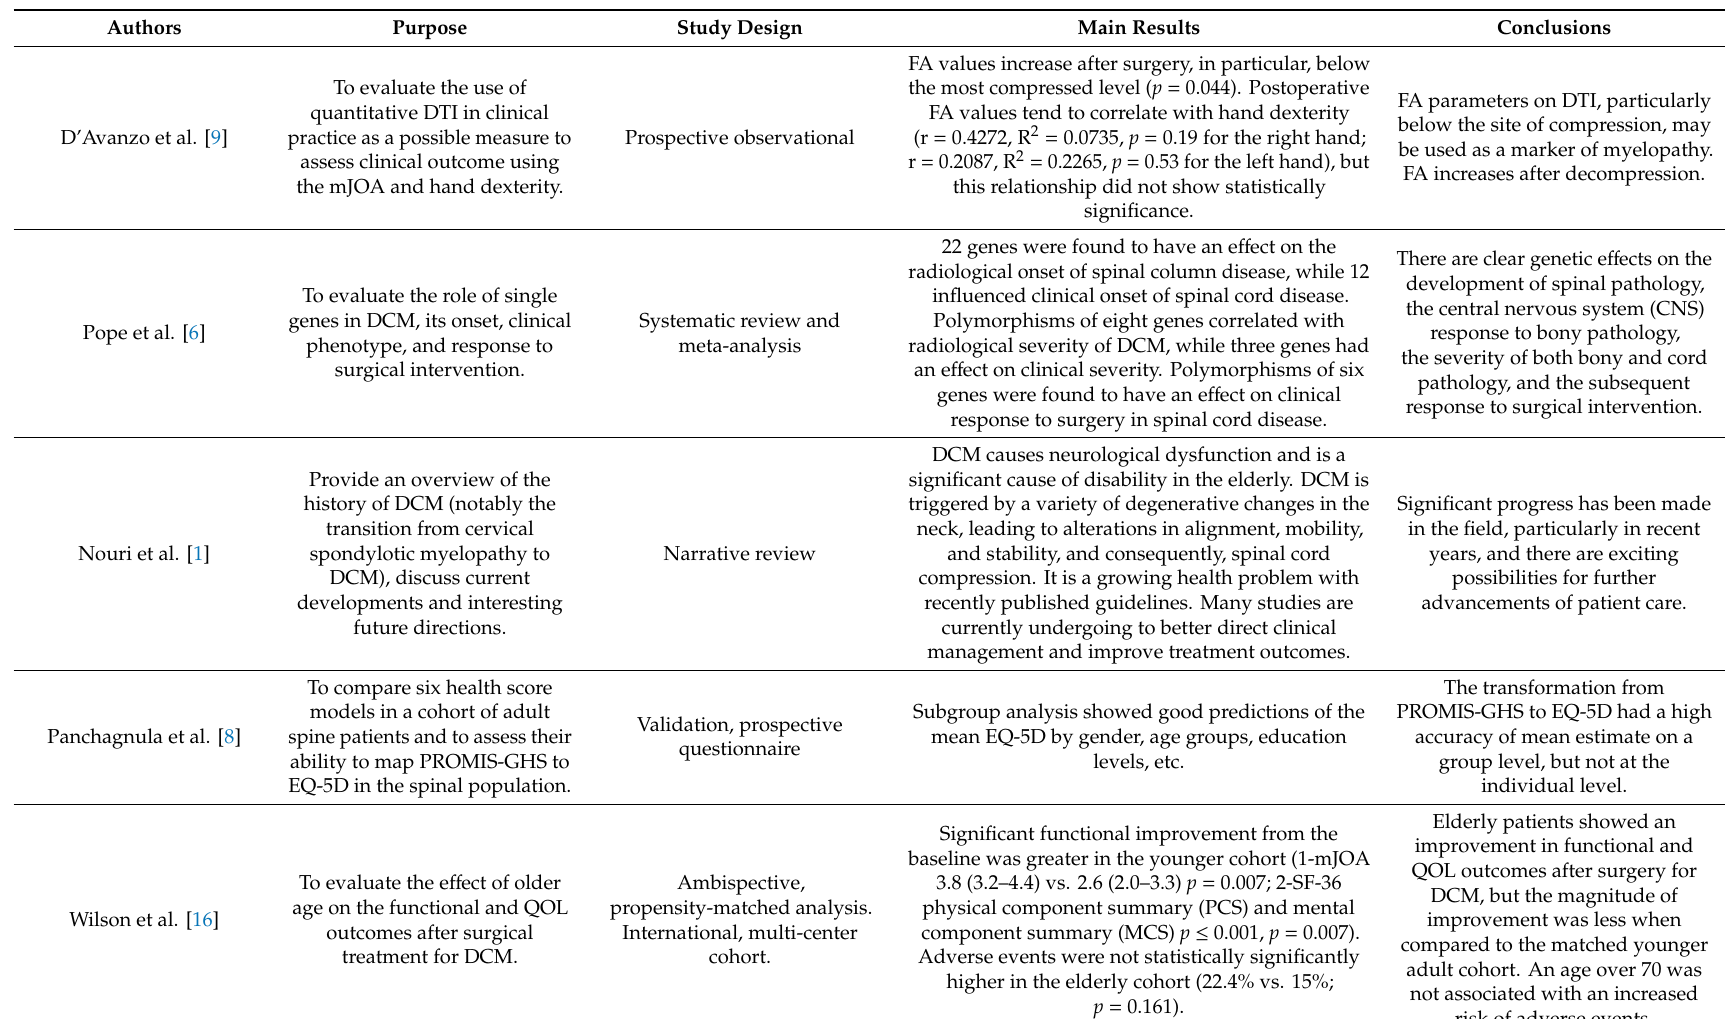
Table 1. Summary of published papers in this Special